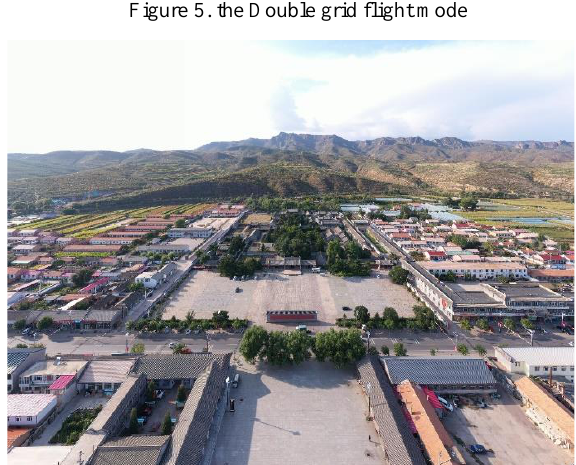
Figure 6. the King Harqin Banner Mansion